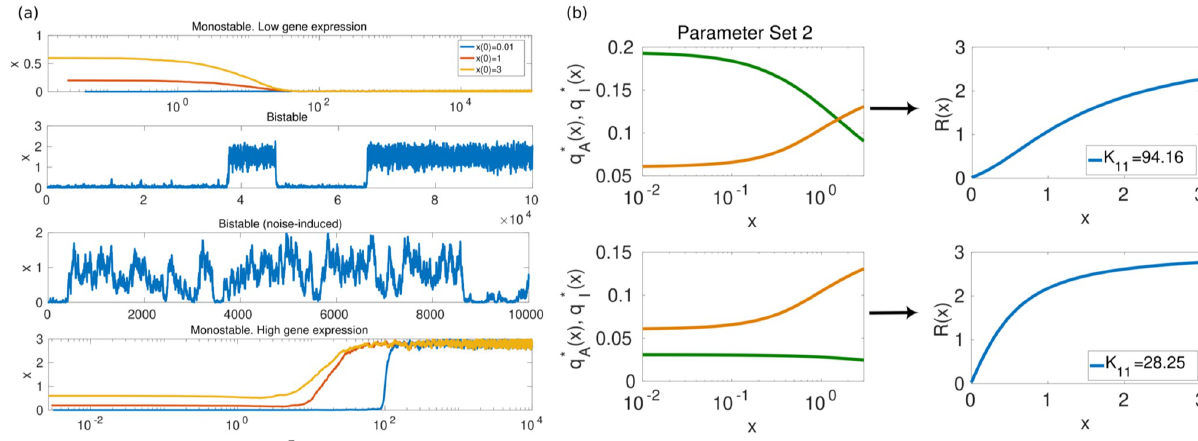
Fig 2. Summary of the model results. Plots in (a) show results of direct simulation of the process (carried out by means of the Gillespie algorithm [50, 51]). These simulations illustrate the four type of behaviours afforded by the stochastic model (from top to bottom): inactive TF, bistability, noise- induced bistability, and active TF. Plots in (b) illustrate one of our main results, namely, that the TF exhibits emergent, non-linear behaviour (e.g. bistability) which could not be observed in the absence of bivalent chromatin. Specifically, we show that such behaviour is associated to the tunability of the effective cooperativity, n eff , of the TF regulatory circuit: by altering the activity of the chromatin-modifying enzymes we can control the quantity n eff . of the KDM that removes H3K27me3), the effective In the particular case shown in the figure, by varying K 11 (which corresponds to the K M cooperativity changes from n > 1 (upper plot) to n � 1 (lower plot). The response curve, R ( x ), and the n of the TF are defined by eff eff eff R ð x Þ ¼ r 1 þ C